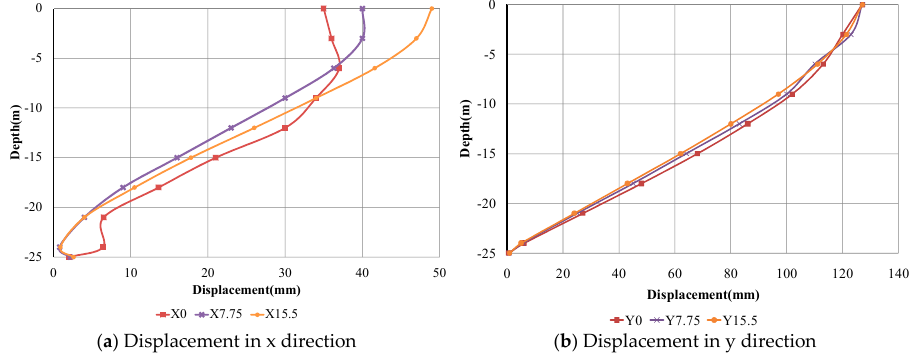
Figure 6. Displacements of selected different distance piles assuming a fixed connection between the piles and the reinforced concrete plate of the platform.